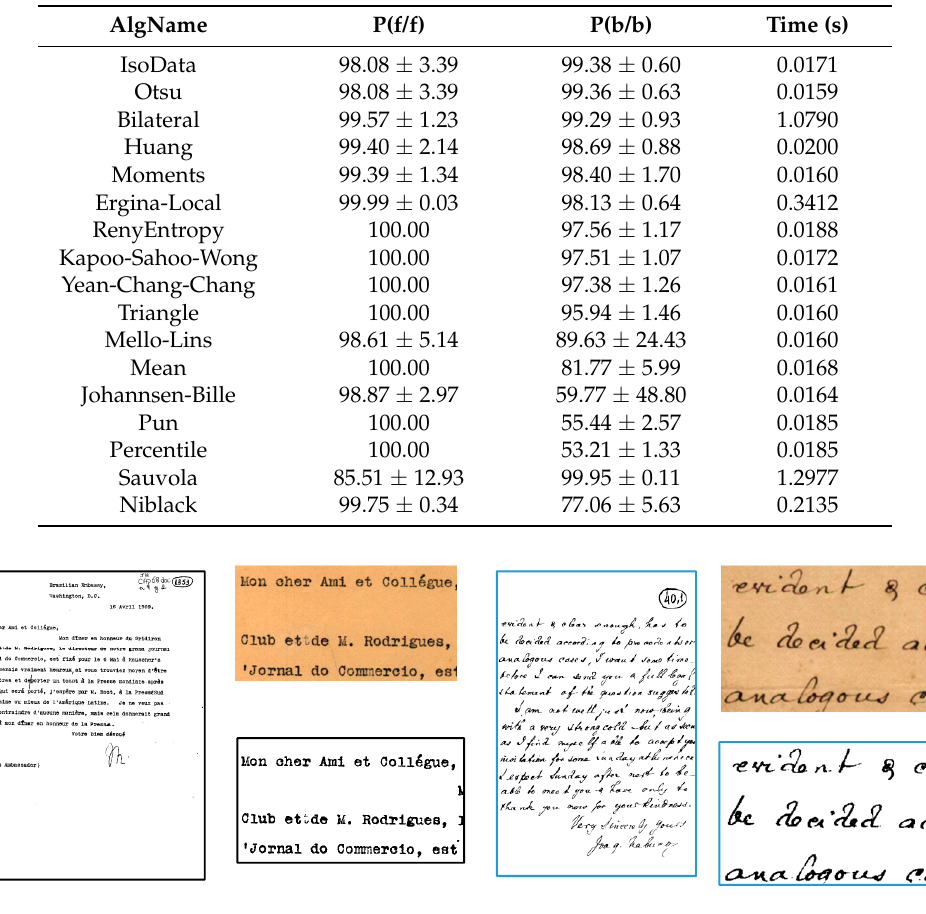
Figure 5. Historical documents from Nabuco bequest with the best (( left )—P(f/f) = 100, P(b/b) = 99.99) and the worst (( right )—P(f/f) = 89.76, P(b/b) = 99.98) binarization results for the bilateral filter with zooms from the original ( top ) and binary ( bottom ) parts.